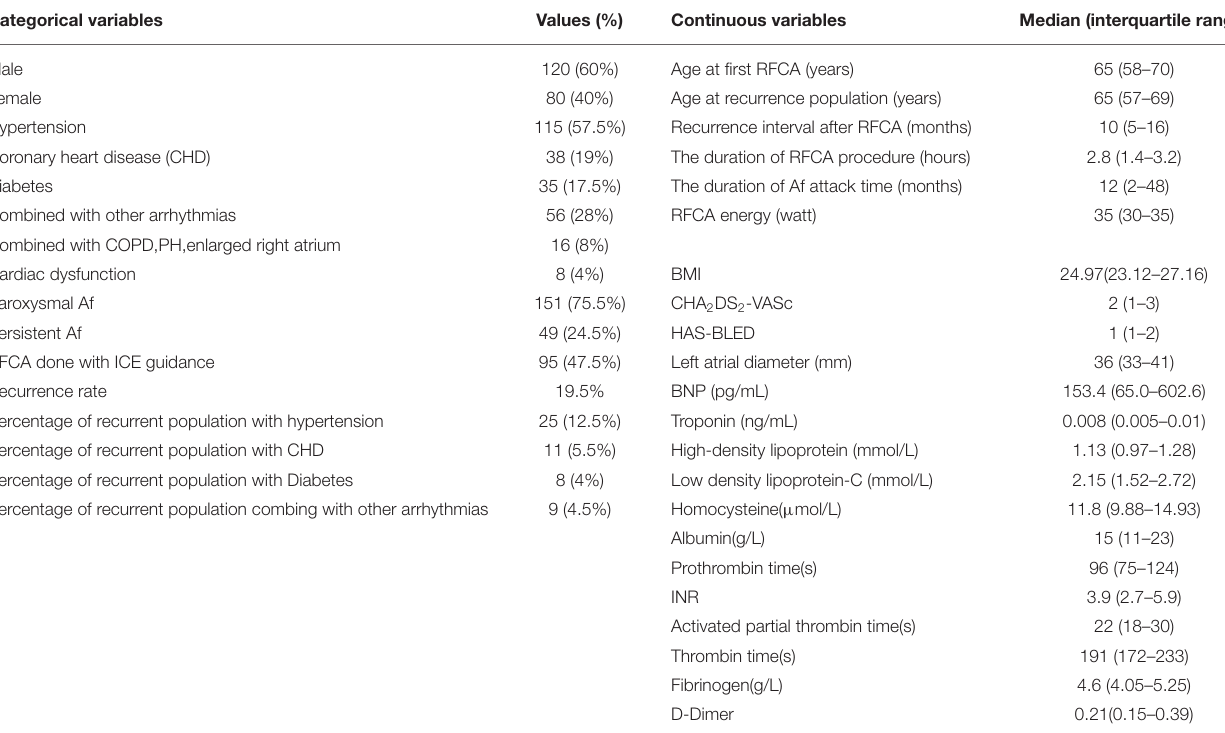
TABLE 1 | Characteristics of participants.